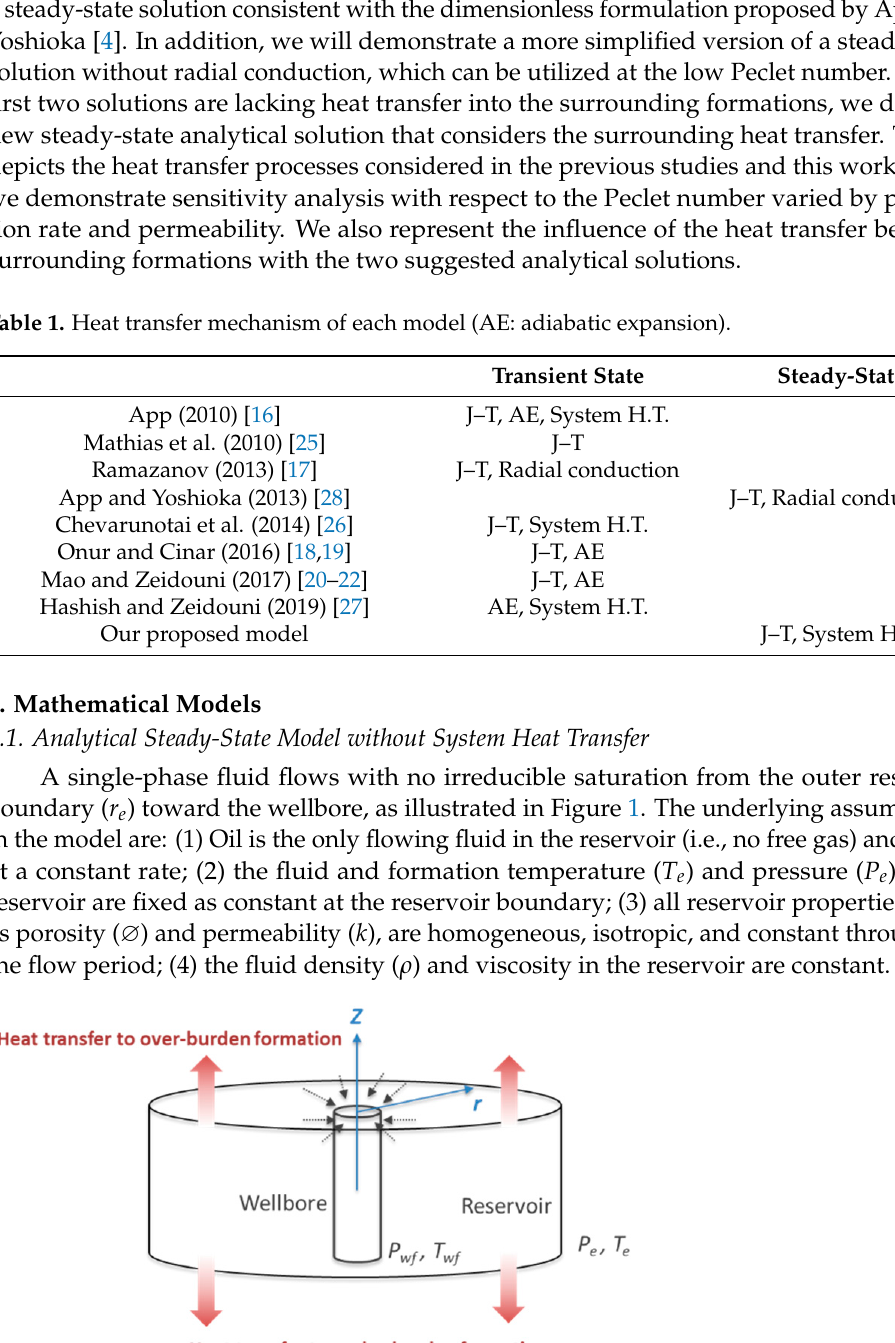
Table 1. Heat transfer mechanism of each model (AE: adiabatic expansion).